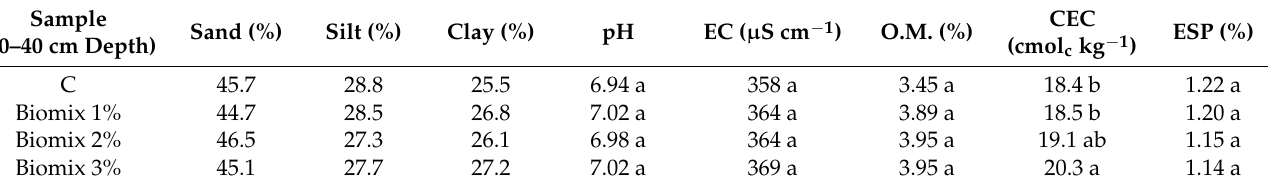
Table 5. Soil texture, pH, EC, O.M., CEC and ESP in the four treatments at 20–40 cm depth z